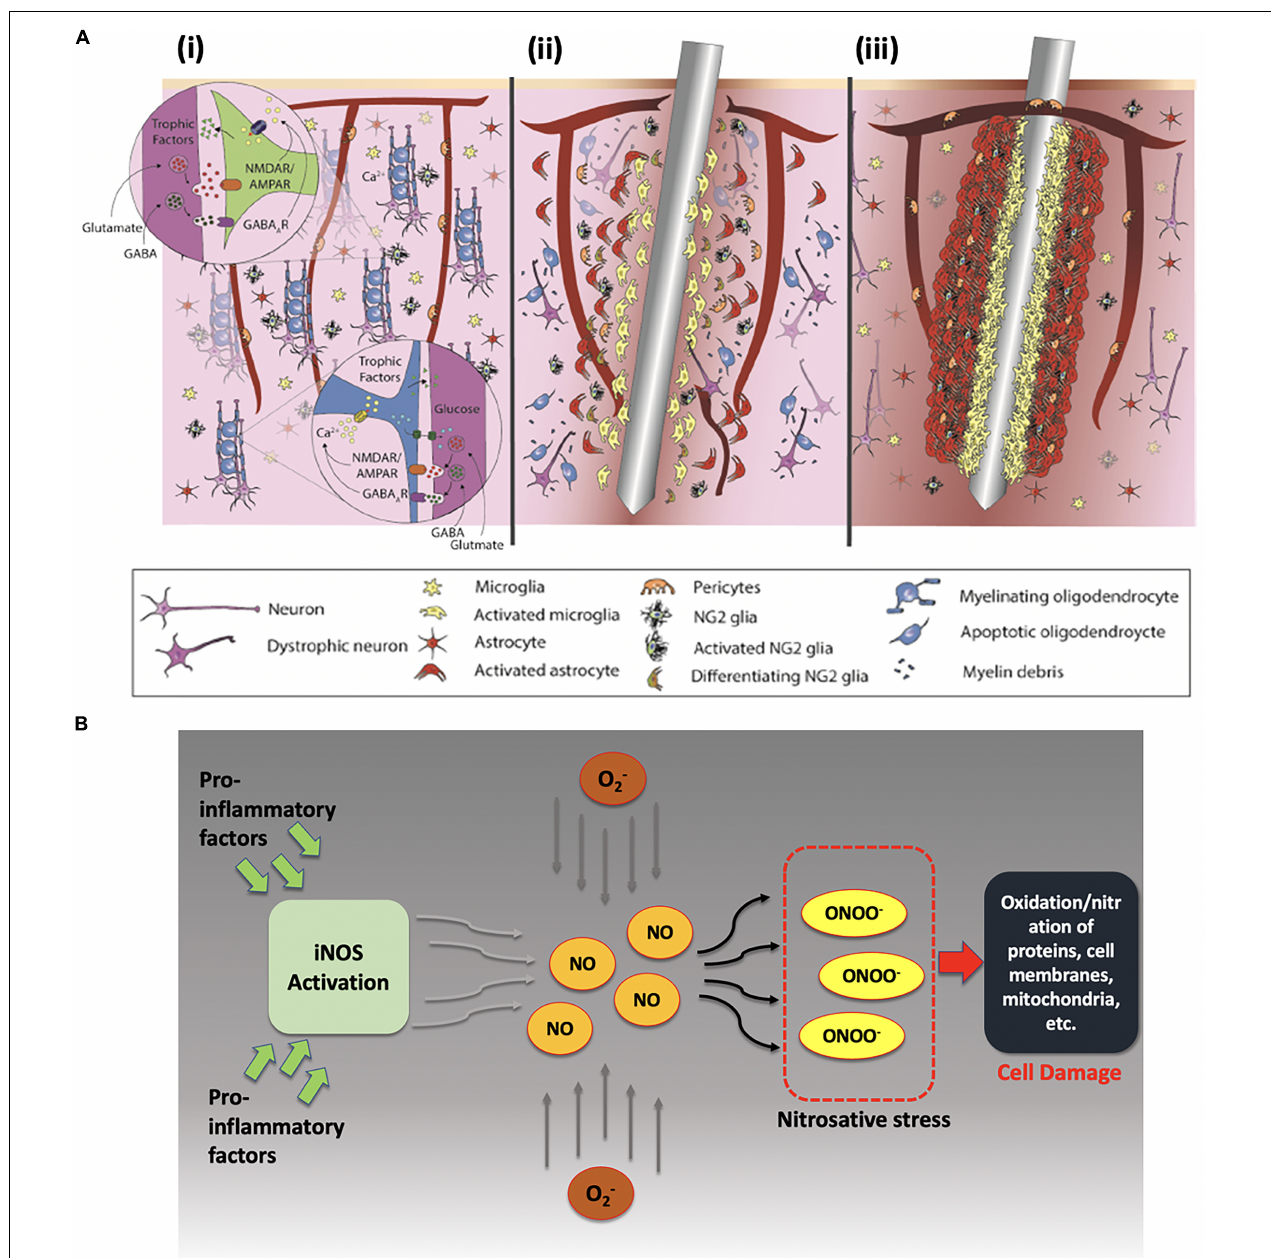
FIGURE 5 | (A) Foreign body response upon electrode insertion. (i) Healthy brain tissue, (ii) acute response upon electrode insertion within 6–8 h, and (iii) chronic response after injury persisting for months. Reprinted with permission from Wellman and Kozai (2017). Copyright (2017) American Chemical Society. (B) Effects of proinflammatory factors on neuronal cells after electrode insertion. Proinflammatory factors activate inducible-nitric oxide synthase (iNOS) that produces nitric oxide (NO) in excessive amounts, which later reacts with reactive oxidative species to form peroxynitrite (a known marker for cell